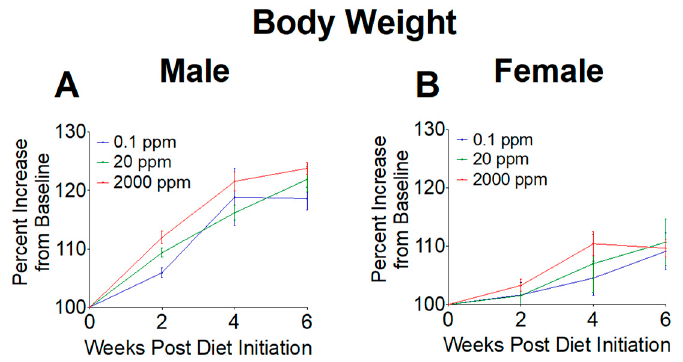
Figure 1. Relative body weights of mice upon initiation of 0.1, 20, and 2000 ppm Mn diets. ( A ) Male mice. ( B ) Female mice. Body weights expressed as percent increase from baseline during 6-week diet period ( n = 6 / sex). Data expressed as mean ± SEM.